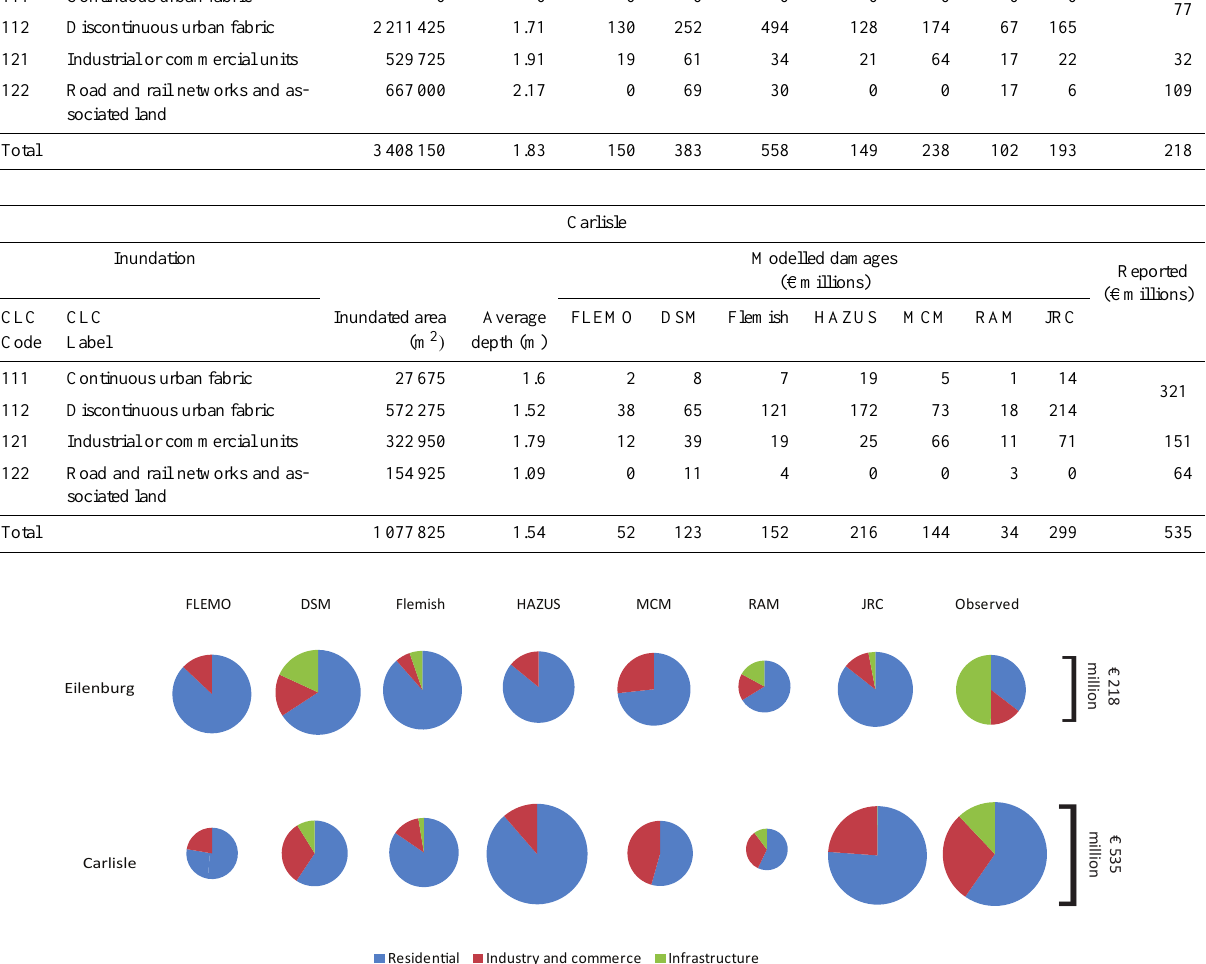
Fig. 7. Magnitude of estimated damages computed by the different models, and the corresponding break-down into individual land use classes. The corresponding numbers can be found in Table 4. Note that the simplified FLEMO, HAZUS and MCM models do not include specific estimates for infrastructure